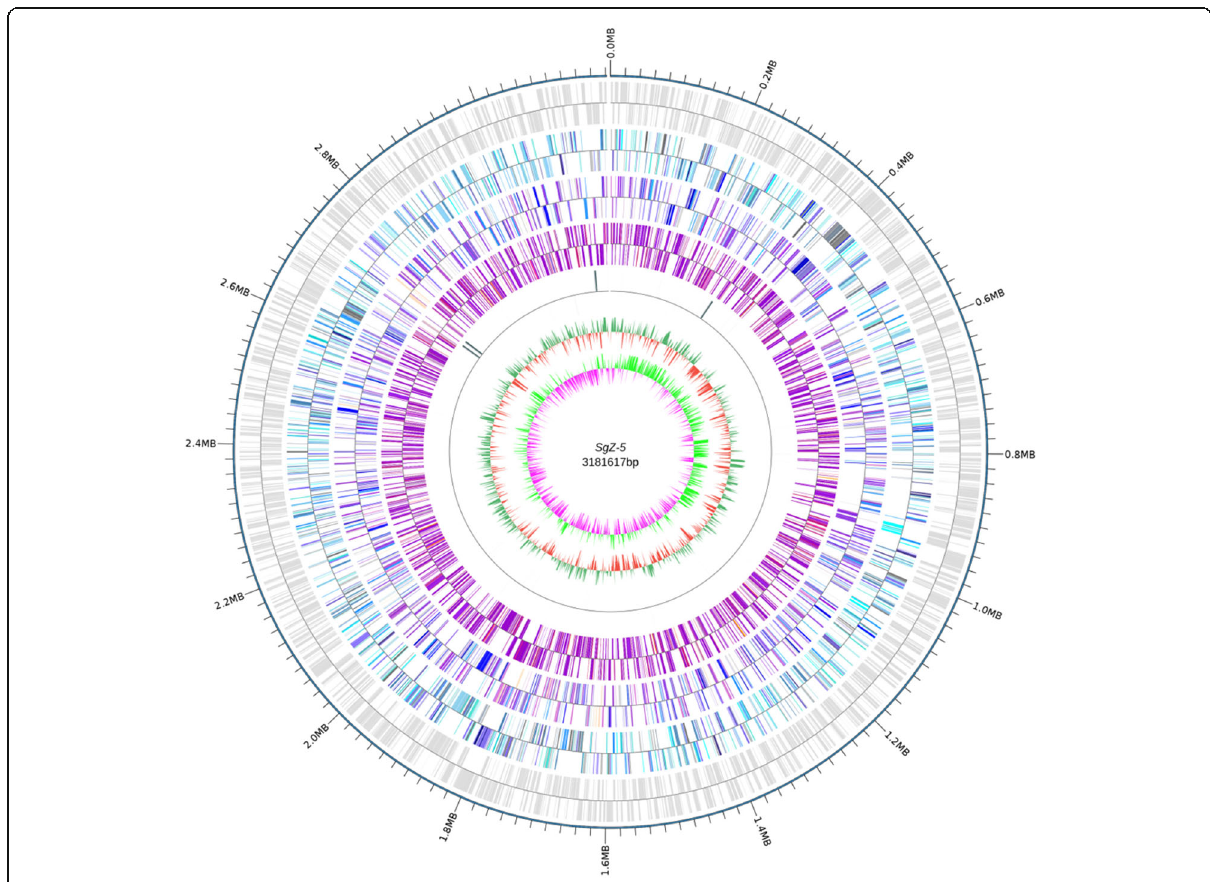
Fig. 3 Circular map of the chromosome of A. humicireducens SgZ-5 T . From center to outside, circle 1 illustrates the GC skew. Circle 2 shows GC content (peaks out/inside the circle indicate values higher or lower than the average G+C content, respectively). Circle 3 denotes ncRNA genes. Circles 4, 5 and 6 indicate the CDSs, colored according to COG, KEGG and GO categories, respectively. Circle 7 demonstrates the predicted protein-coding